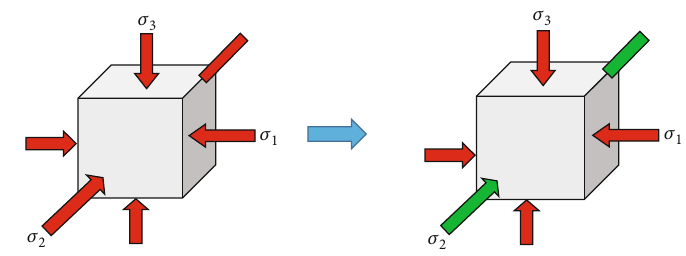
Figure 4: Loading and unloading 3D schematic (path